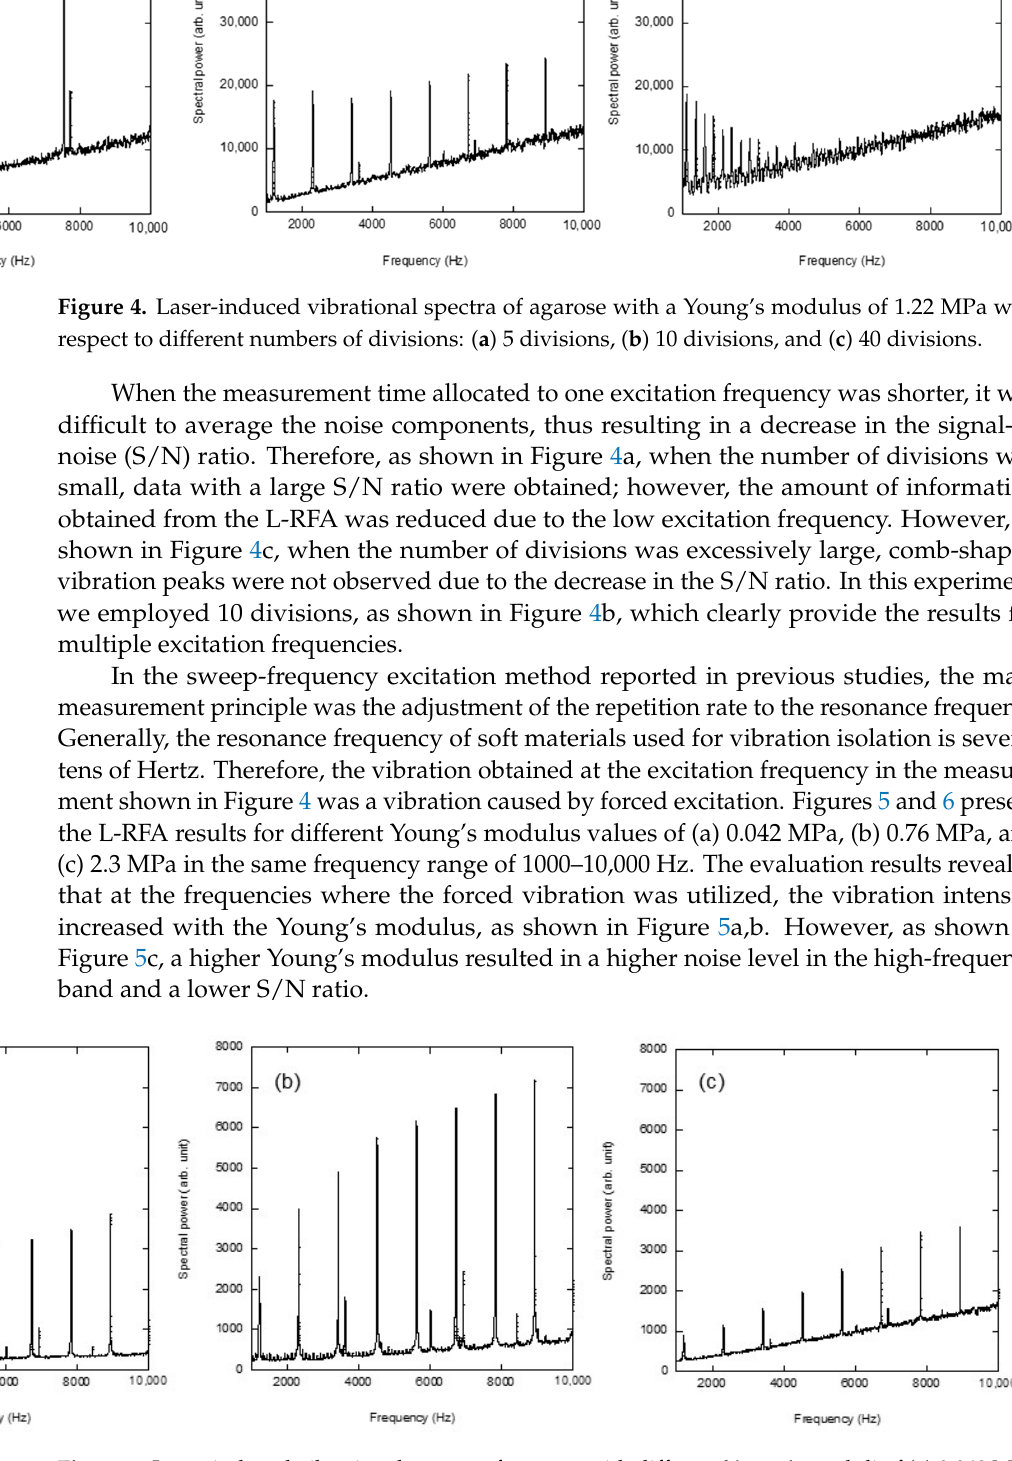
Figure 6. Laser-induced vibrational spectrogram of agarose with Young’s moduli of ( a ) 0.042 MPa, ( b ) 0.76 MPa, and ( c ) 2.3 MPa. 3.2. Young’s Modulus Prediction by Machine Learning Analysis The final clinical application of this technology will be the stiffness measurement us- ing L-RFA for in vivo soft tissue tumors by introducing optical fibers into an endoscope or other devices. Therefore, it is critical to obtain a more accurate Young’s modulus from the obtained L-RFA results for application to CADe. To avoid learning extrapolation, the estimation performance was verified for nine agarose samples, excluding the largest and smallest datasets. Figure 7a presents the results of 10 measurements for each agarose sam- ple used to train 100 data points and predict the 10 data points of a verified agarose sam- ple. The variation in the estimated values for each Young’s modulus was significantly large, and a sufficient estimation performance was not demonstrated. Moreover, Figure 7b presents the estimation results of one data point using the training data of 10 points by considering the average of the data measured at 10 points for each agarose sample. A comparison of the values is shown in Table 1. The coefficient of determination R 2 reached 0.950 and the mean squared error was 0.0322. The estimation results were close to an ideal approximate straight line ( y = x ), such that a linear approximation with a high coefficient of determination was obtained. This result indicates that although a large amount of train- ing data is essential, averaging and sufficient data quality are more critical than the amount of data. Based on the results of this study, the Young’s modulus estimation using SVR can be fully utilized.